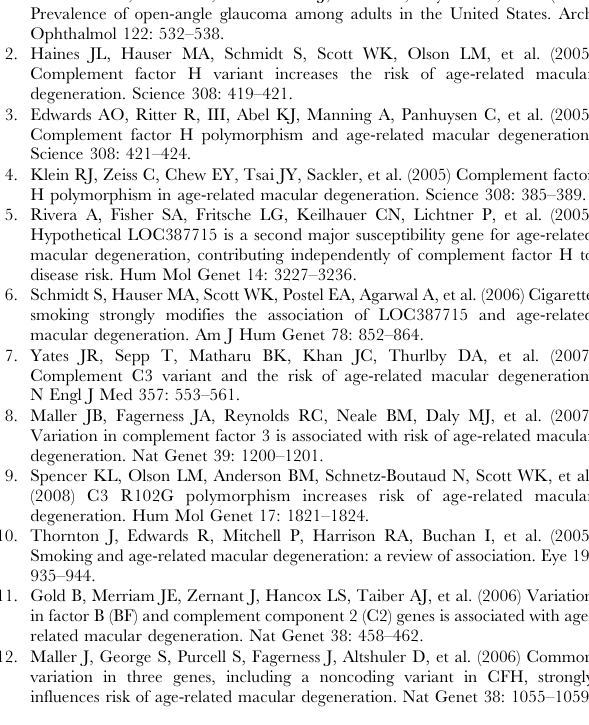
Figure S4 Neural network model developed in the ARMA dataset. W= weight, PADD = addition function.